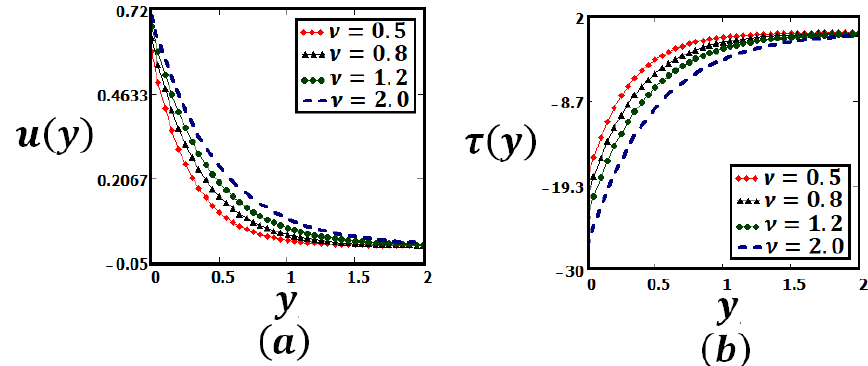
Figure 7: Profiles of the velocity field u ( y , t ) and the shear stress τ ( y , t ) for fractionalized Jeffrey fluid given by Eqs. (16) and (21), for A =